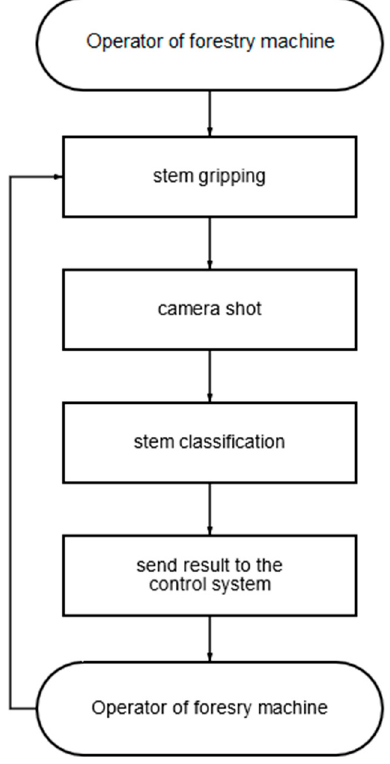
Figure 5. Research result in the form of an algorithm/flowchart. Table 1. Magnitude of the average value of Sørensen–Dice coefficient depending on the number of epochs of training.